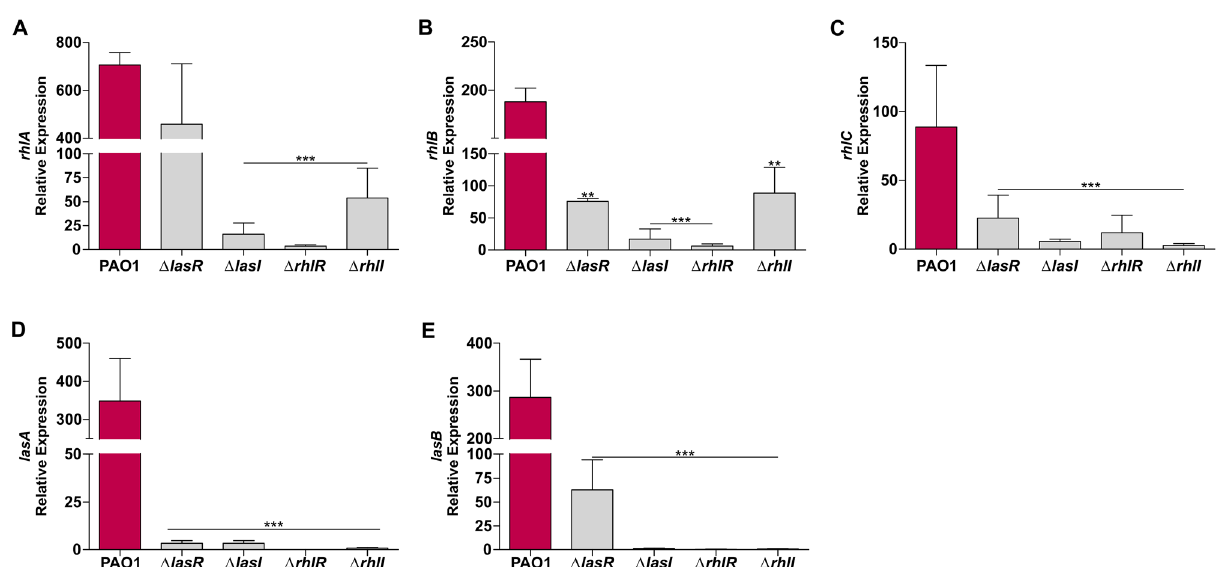
Figure 4. Inactivation of LasRI and RhlRI QS systems reduces virulence factor expression. Relative expression levels of virulence factor genes ( A ) rhlA, ( B ) rhlB, ( C ) rhlC, ( D ) lasA and ( E ) lasB . Relative expression levels were quantified in the stationary phase (indicated by red arrow) of growth by qRT-PCR. Error bars represent S.D. ± (n = 3 biological replicates). All mutant data was analysed relative to PAO1 expression values. Significance was determined by a one-way ANOVA followed by Dunnett’s multiple comparison test (* p < 0.05, ** p < 0.01, *** p <